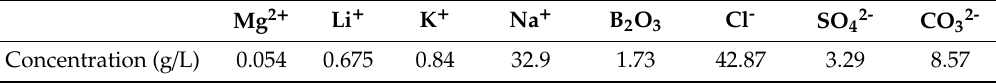
Table 1. The chemical composition of the brine after separating Mg2 + ions